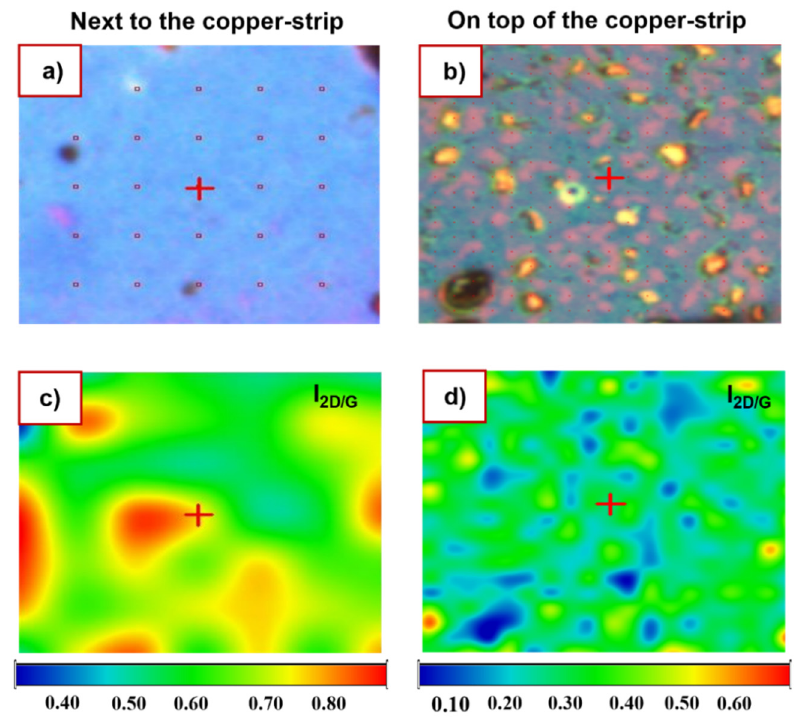
Figure 3. Raman mapping for graphene growth on SiO 2 /Si substrate. Where ( a , b ) represent the optical images of the selected mapping area (150 × 100 µ m 2 ) next to and on top of the copper-strip, respectively. ( c , d ) show the ratio between the intensity of 2D/G peaks in the same areas as in ( a , b